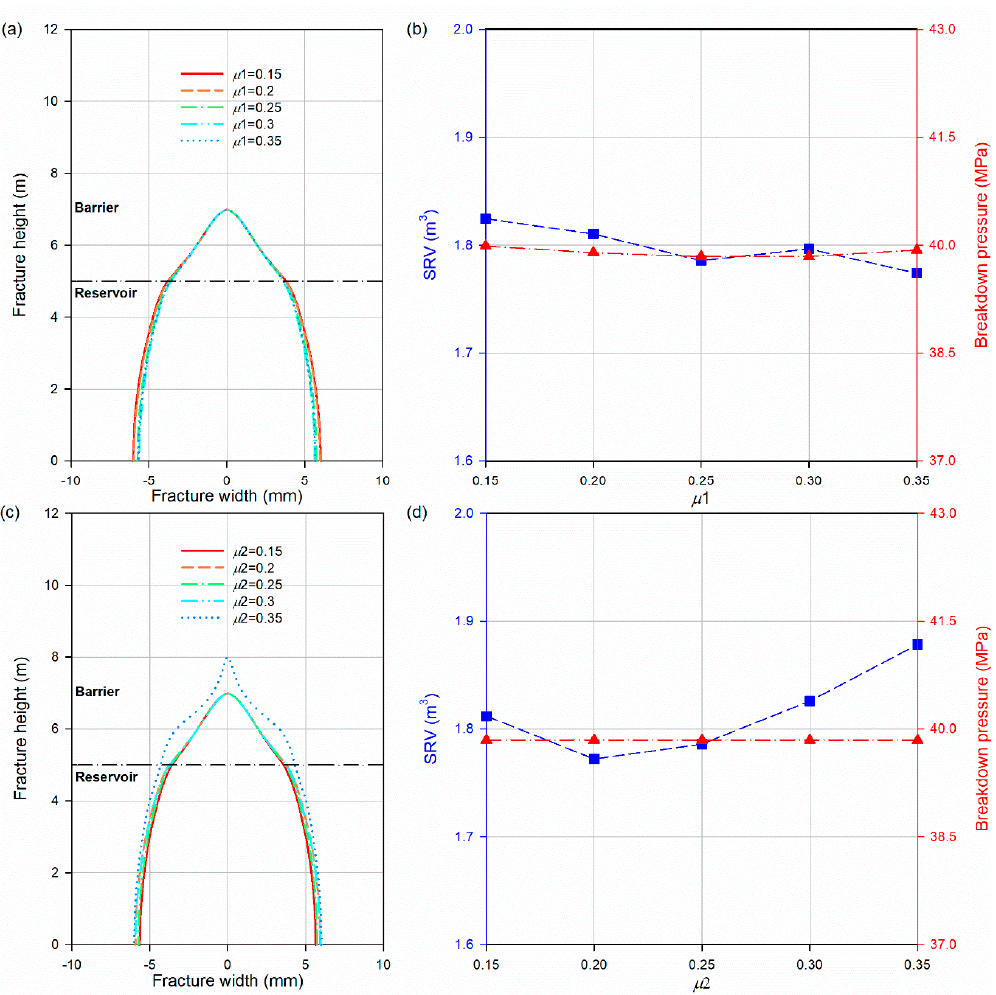
Figure 14. Fracture morphology, SRV, and breakdown pressure under di ff erent Poisson’s ratios. ( a ) Profiles of fractures under di ff erent reservoir Poisson’s ratio µ 1; ( b ) SRV and breakdown pressure under di ff erent µ 1; ( c ) profiles of fractures under di ff erent barrier Poisson’s ratio µ 2; ( d ) SRV and breakdown pressure under di ff erent µ 2.